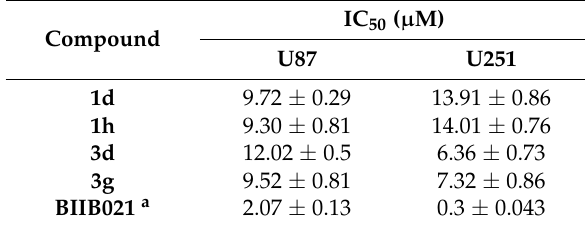
Table 3. Selected compounds studied for half maximal inhibitory concentration (IC50) in U87 and U251 cell